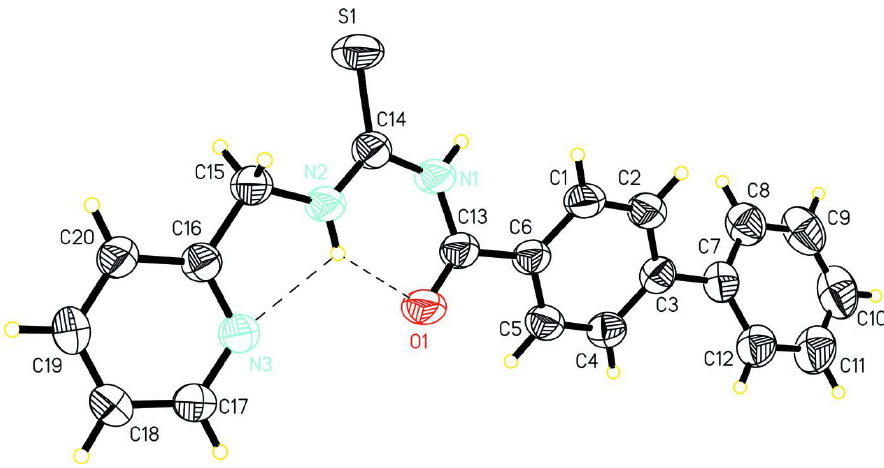
Figure 1 The molecular structure of (I), with displacement ellipsods are drawn at the 50% probability